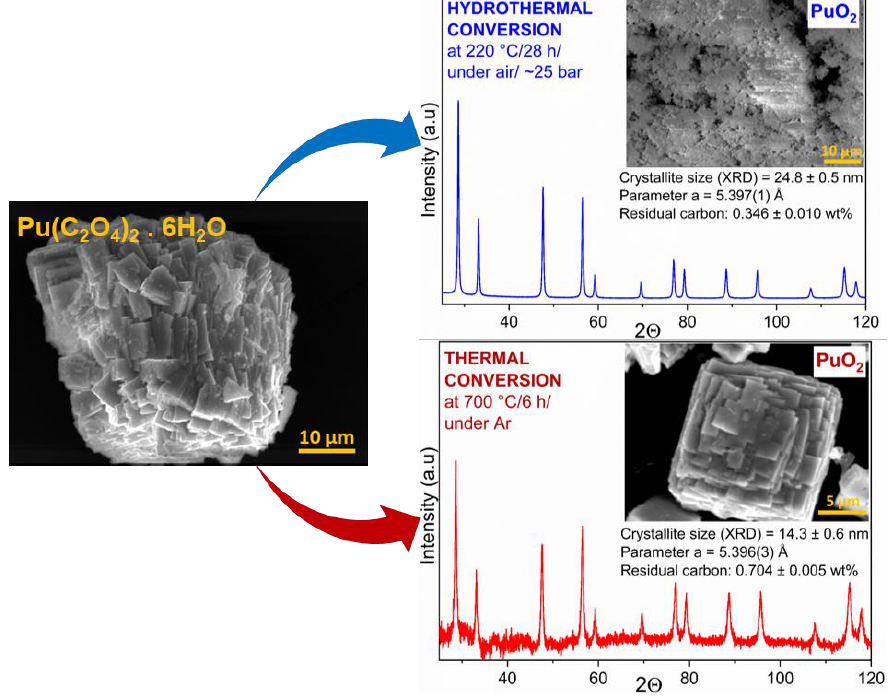
Figure 4. Scanning-electron micrographs of Pu(C 2 O 4 ) 2 ·6H 2 O ( left ) and PuO 2 samples prepared by hydrothermal ( top ) and thermal conversion ( bottom ) of Pu(IV) oxalate, together with the corresponding XRD patterns, crystal properties and residual carbon content.